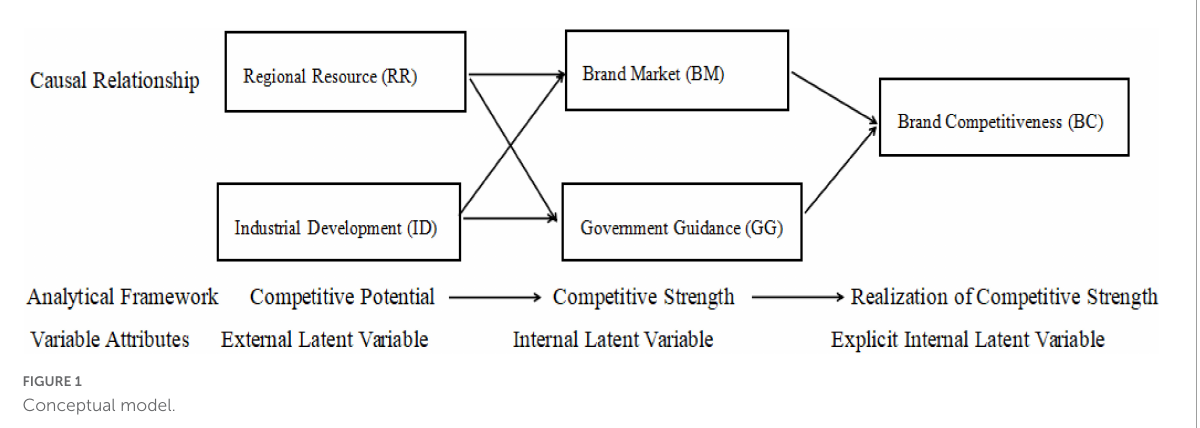
FIGURE1 Conceptual